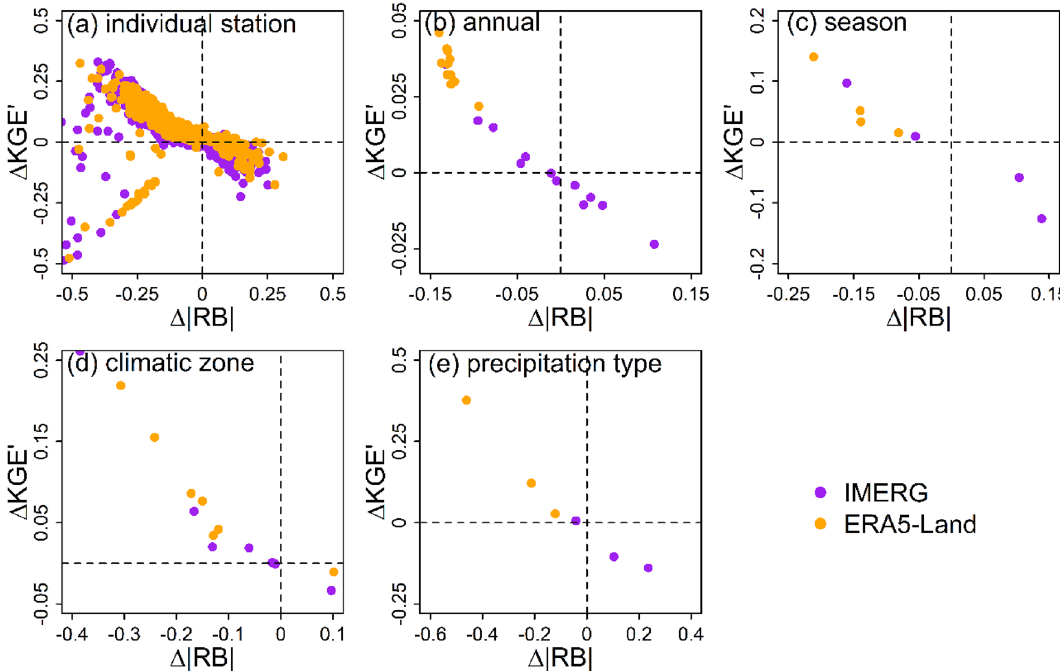
Figure 9. Correlations of ∆KGE ʹ with ∆|RB| for IMERG and ERA5-Land at individual station scale ( a ),